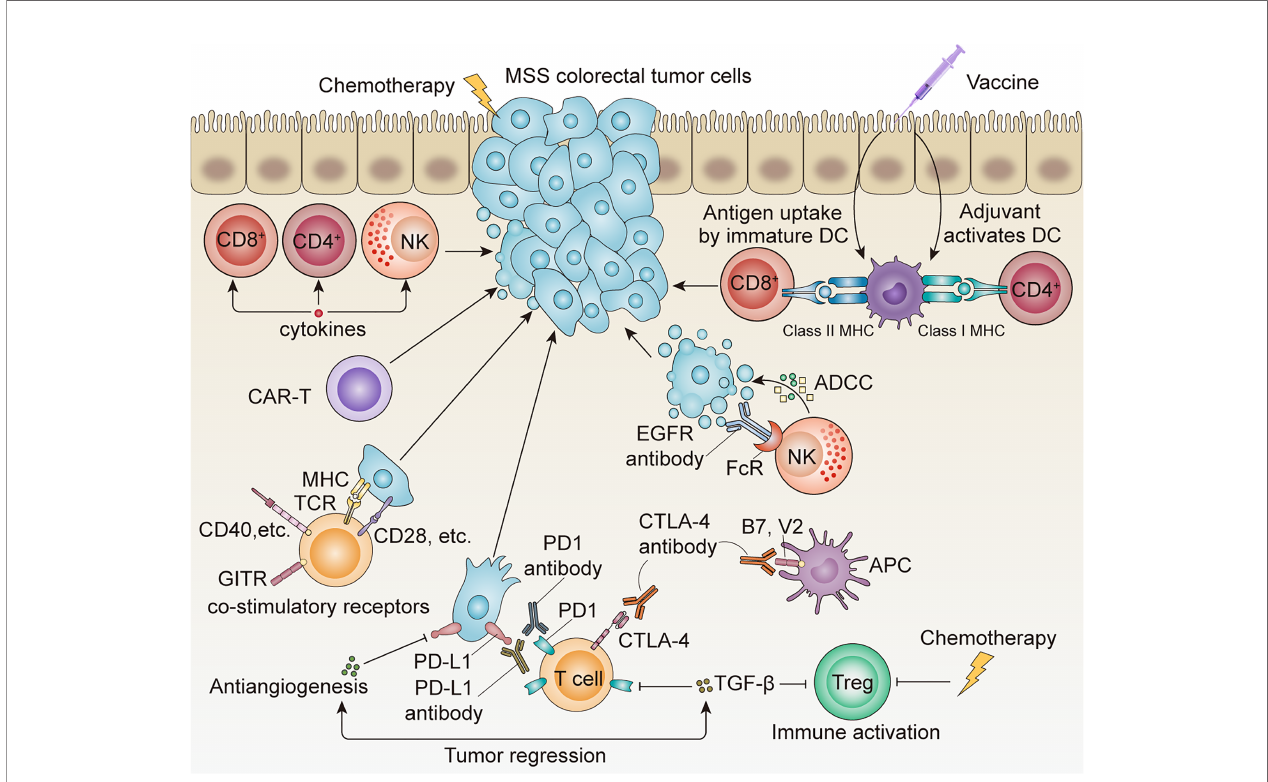
FIGURE 1 | Application of multiple adaptive immunotherapies in MSS CRC. ICI monotherapy is often ineffective, and the combination of chemotherapy, antiangiogenesis therapy, anti-EGFR antibody, and other systemic therapies is expected to achieve better therapeutic